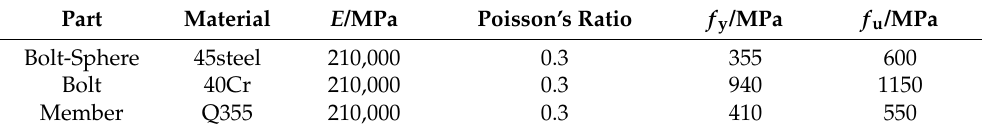
( c ) Figure 14. FE model of a typical bolt-sphere joint with members: ( a ) the whole mode; ( b ) the bolt-sphere; ( c ) the cone-head. 4.2. Comparison and Verification The above material constitutive and modeling methods were used for the numerical simulation of the uncorroded bolt-sphere connections, and the load-displacement curves and stress diagrams of the bolt-sphere connections are shown in Figures 15 and 16.